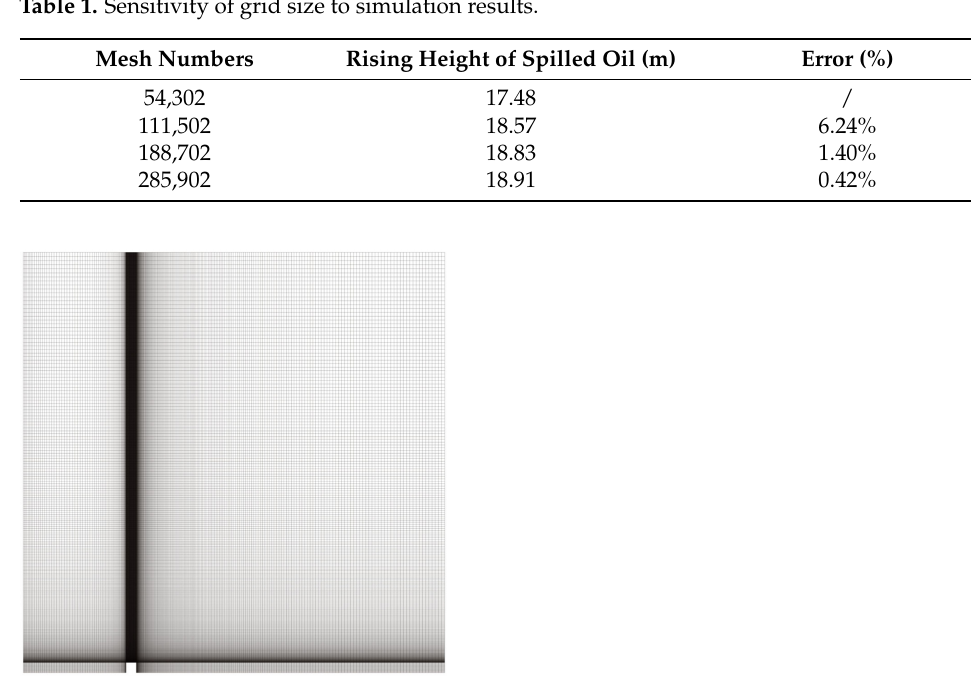
Figure 2. Computational grid and solution domain.